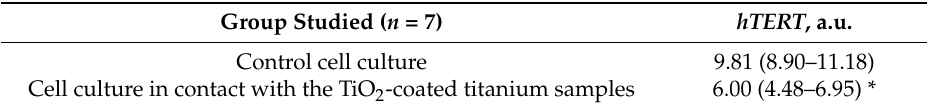
Table 3. hTERT expression levels in Jurkat T cells after 24 h of culture in the presence of a model matrix consisting of a TiO 2 coating on a titanium substrate, Me (Q 1 –Q 3 ).